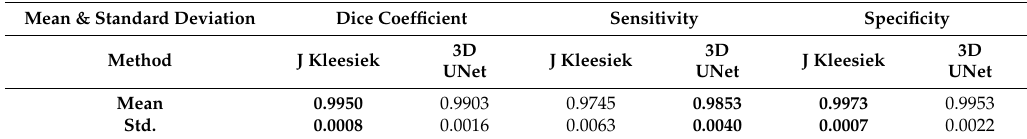
Table 3. Comparison of mean and standard deviation for J Kleesiek’s method and 3D U-Net. The best values are